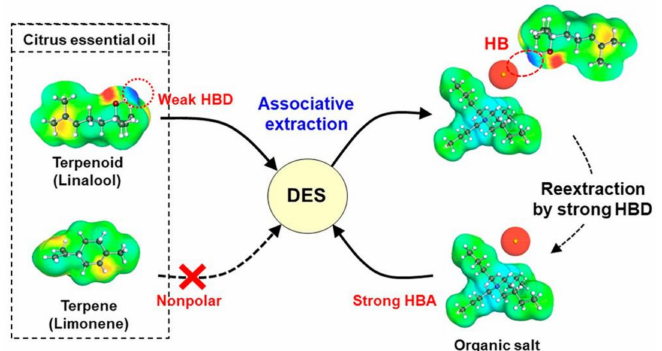
Figure 2. Citrus essential oil deterpenation approach intensified by in situ formation of a DES between a quaternary salt and terpenoids. Reprinted from Li, J.; Wang, J.; Wu, M.; Cheng, H.; Chen, L.; Qi, Z. Deep Deterpenation of Citrus Essential Oils Intensified by in Situ Formation of a Deep Eutectic Solvent in Associative Extraction. Industrial and Engineering Chemistry Research, 2020, 59 (19), 9223–9232. with permission from American Chemical Society [42]. Copyright